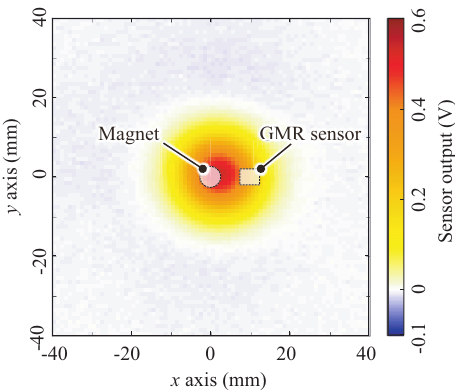
Figure 11. Measured spatial response with a sponge sheet instead of the base elastomer sheet at a depth of 4 mm. The shape of spatial response exhibits an approximately elliptical Gaussian-like shape whose major axis corresponds to the line connecting the centers of the magnet and GMR